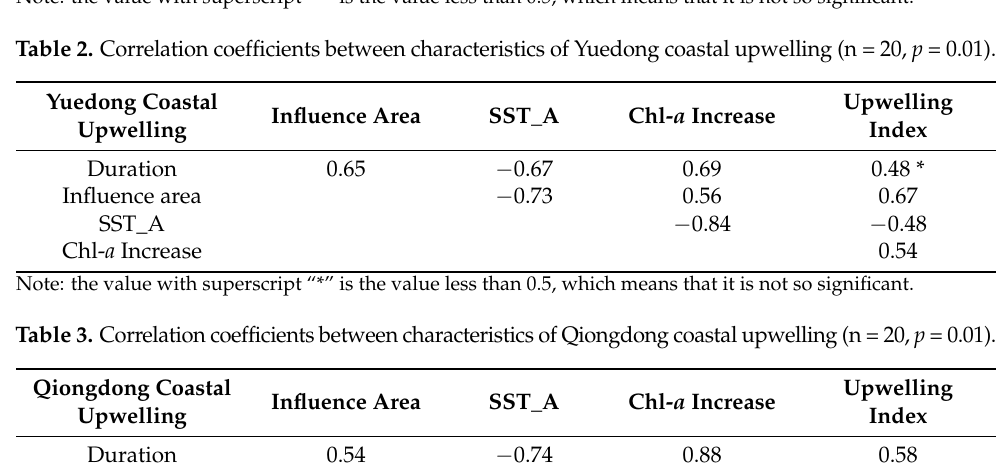
Table 1. Correlation coefficients between characteristics of Minnan coastal upwelling (n = 20, p = 0.01). Minnan Coastal Influence Area SST_A Chl- a Increase Upwelling Duration 0.47 * − 0.78 0.70 0.66 Influence Area − 0.80 0.68 0.32 * SST_A − 0.88 − 0.67 Chl- a Increase 0.65